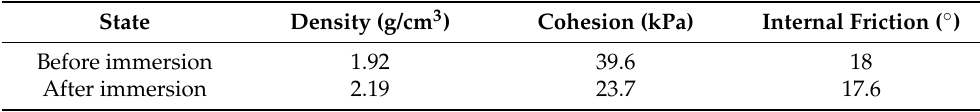
Table 1. Physical and mechanical properties of expansive soil.